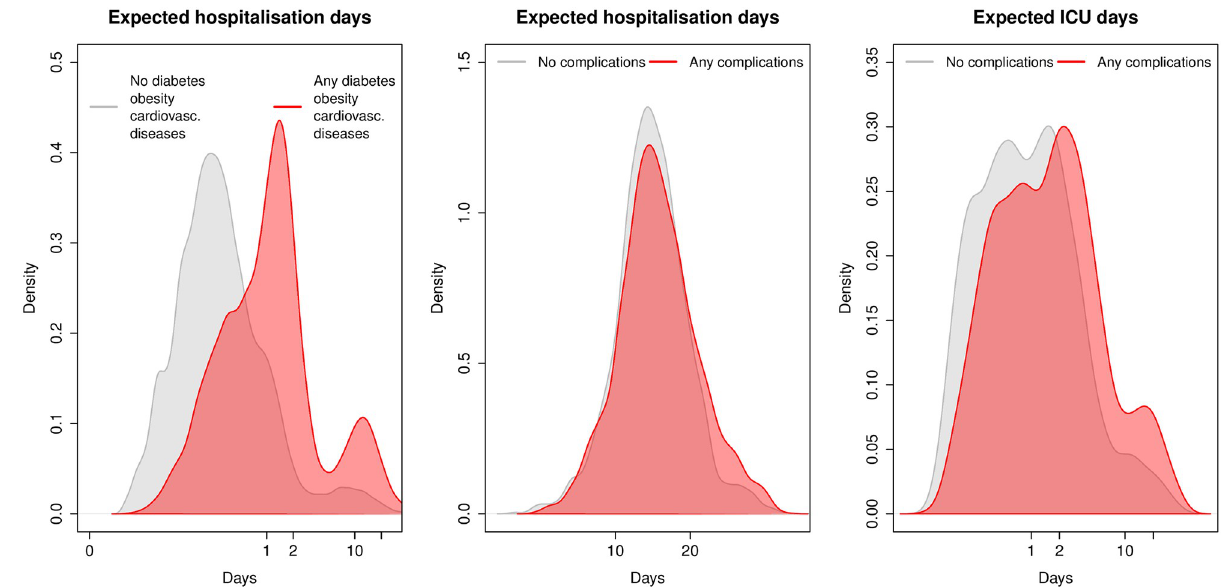
Fig 4. Expected length of stay distribution. The left panel shows the distribution of hospital length stays for patients with and without previous pathologies (obesity, diabetes or cardiovascular diseases). The middle panel shows the distribution of hospital length stays for patients with and without complications. The right panel shows the distribution of ICU length stays for patients with and without complications.